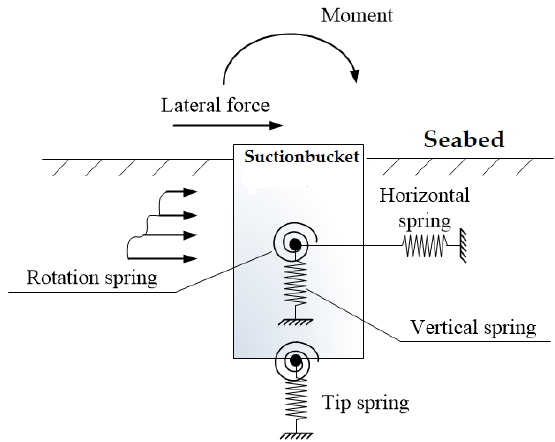
Figure 6. New soil model for a suction bucket pile with both translational and rotational nonlinear springs.